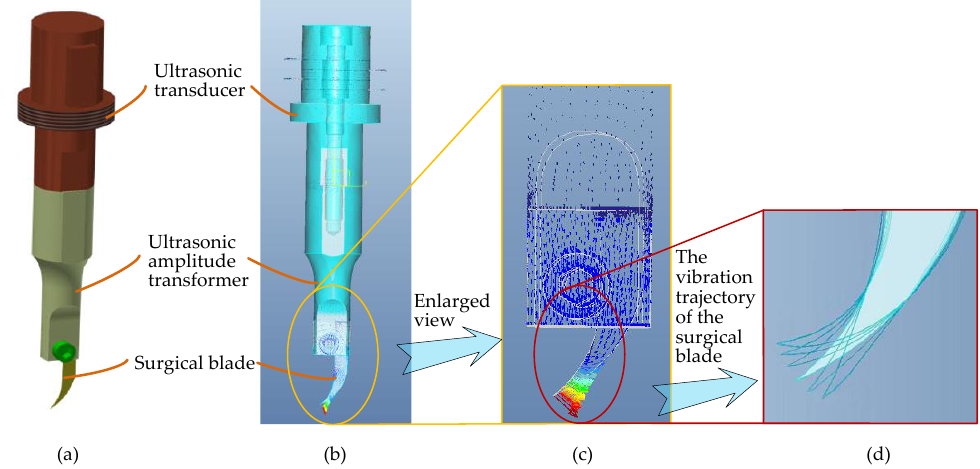
Figure 9. Three-dimensional entity modeling and a modal analysis of the end effector through simulation software, Pro/E. ( a ) Three-dimensional entity modeling of the end effector. ( b ) Modal analysis of the end effector. ( c ) Enlarged view of the surgical blade in the modal analysis. ( d ) Two-dimensional elliptical ultrasonic vibration trajectory of the tip of the surgical blade.